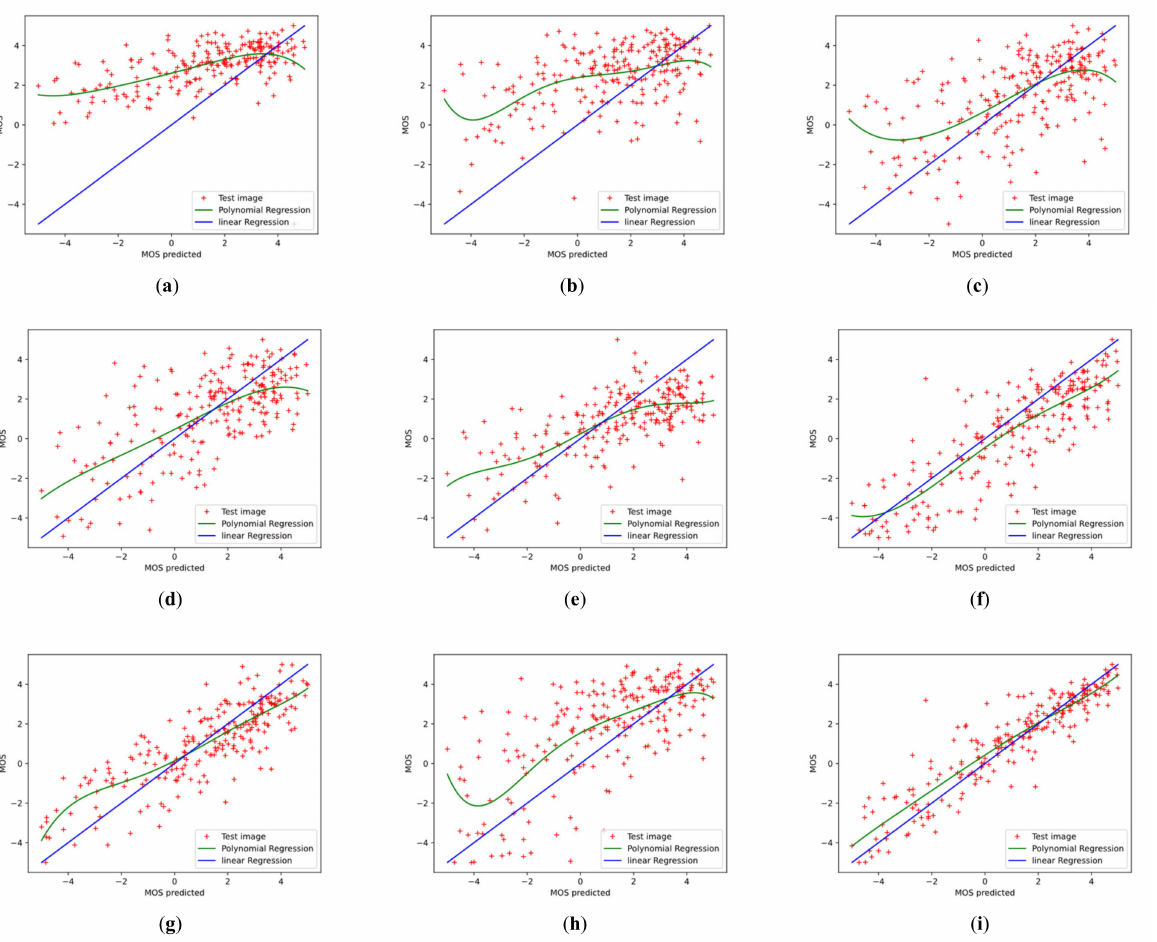
Figure 12. Scatter plots of ground-truth mean opinion scores (MOS) against predicted scores of ( a – f ) different algorithms on LIVEC datasets. The red points denote the testing instances. The blue line is the ideal linear relationship between MOS and the prediction score. The green line is the curve fitted using the test instance. Higher correlation means better performance of the IQA